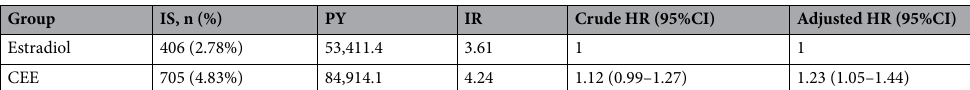
Table 2. Hazard ratios for ischemic stroke in the estradiol and conjugated equine estrogen groups. Cox regression model was adjusted for age, comorbidities, and other characteristics listed in Table 1. IS, ischemic stroke; PY, person-year; IR, incidence rate; HR, hazard ratio; CEE, conjugated equine estrogen.